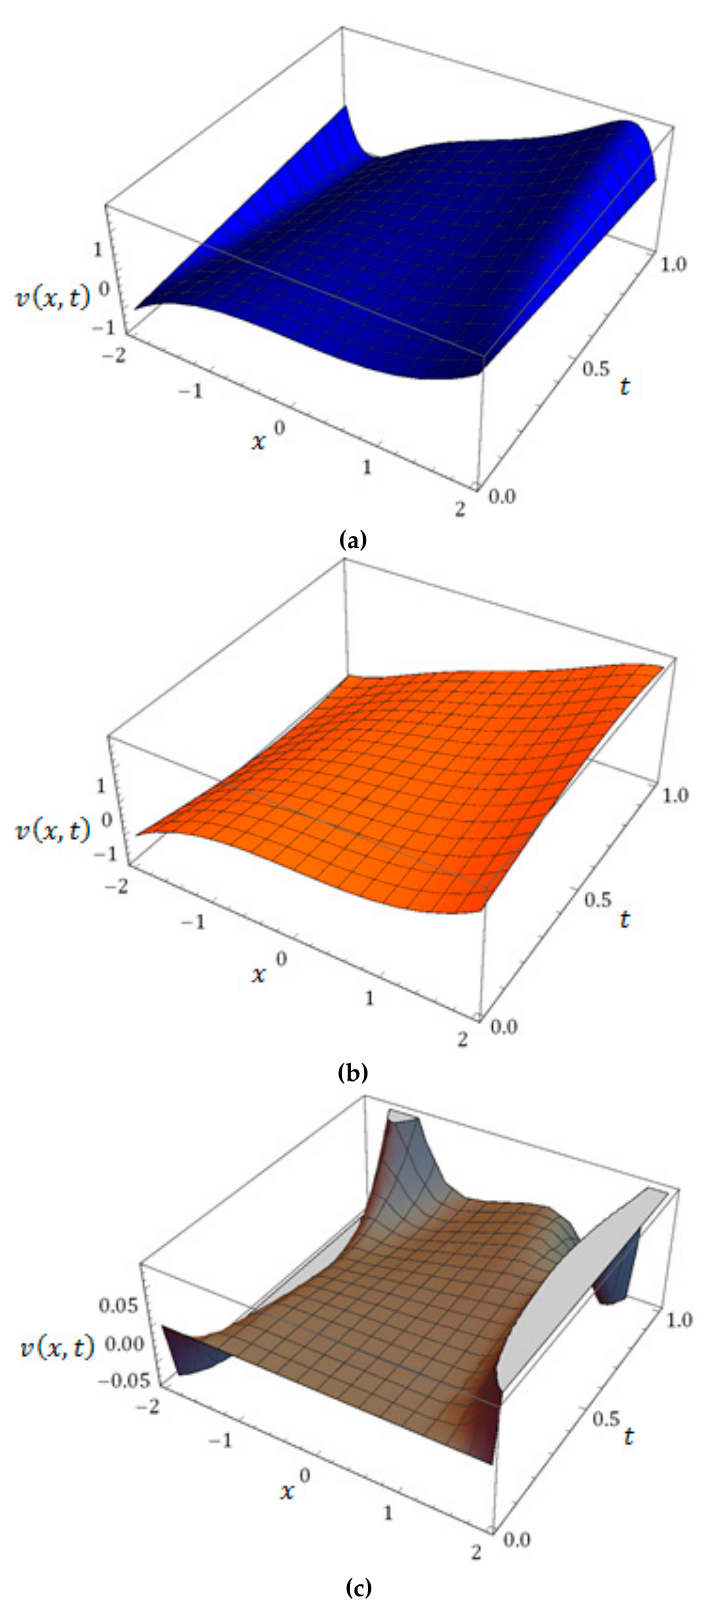
Figure 1 . (a) Response of the q-homotopy analysis transform method ( 𝑞 -HATM) solution. (b) Nature Figure 1. ( a ) Response of the q-homotopy analysis transform method ( q -HATM) solution. of Exact solution. (c) Surface of Absolute error = (cid:3627)𝑣 (cid:3006)(cid:3051)(cid:3028)(cid:3030)(cid:3047) − 𝑣 (cid:3044)(cid:2879)(cid:3009)(cid:3002)(cid:3021)(cid:3014) (cid:3627) for case (𝑖) at 𝜌 = −0.5,𝜀 = ( b ) Nature of Exact solution. ( c ) Surface of Absolute error = 0.5, ℏ = −1,𝑛 = 1 , and 𝜇 = 1. ρ = − 0.5, ε = 0.5, (cid:125) = − 1, n = 1, and µ =